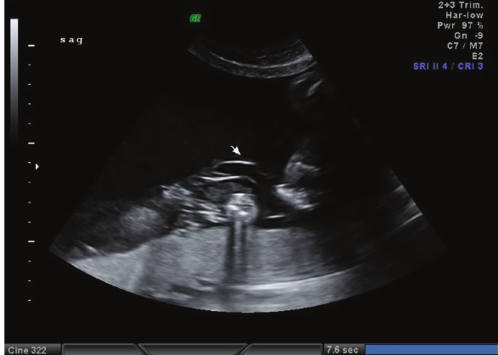
Figure 2: Spontaneous septostomy noted at 26 wks. Layers of membrane noted adjacent to